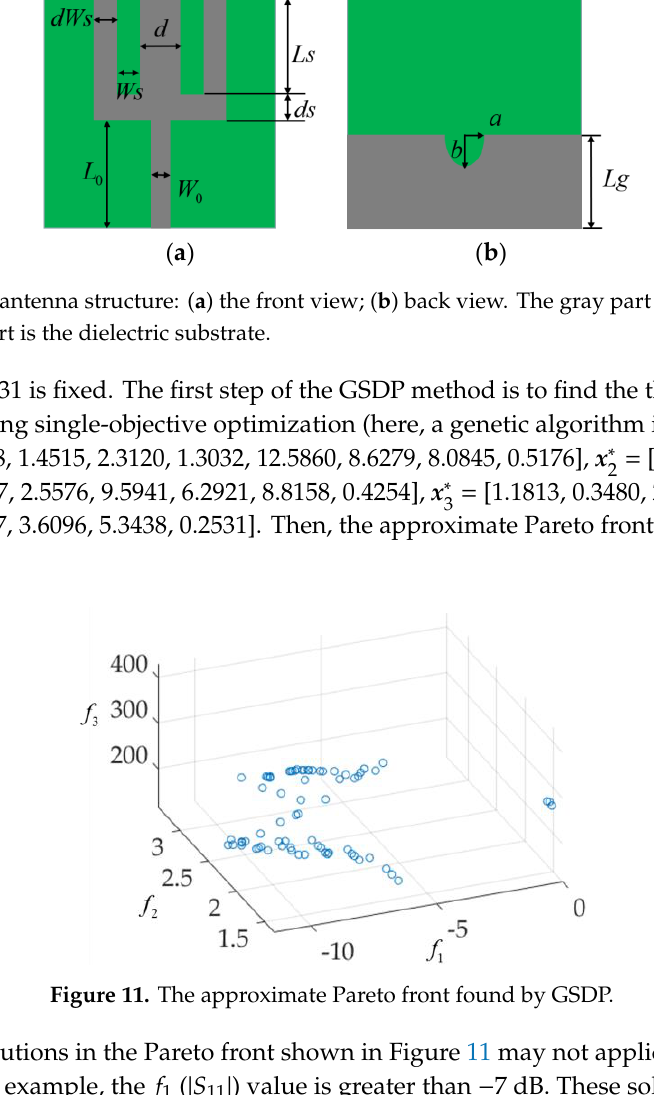
Figure 12. The applicable designs for the UWB antenna.